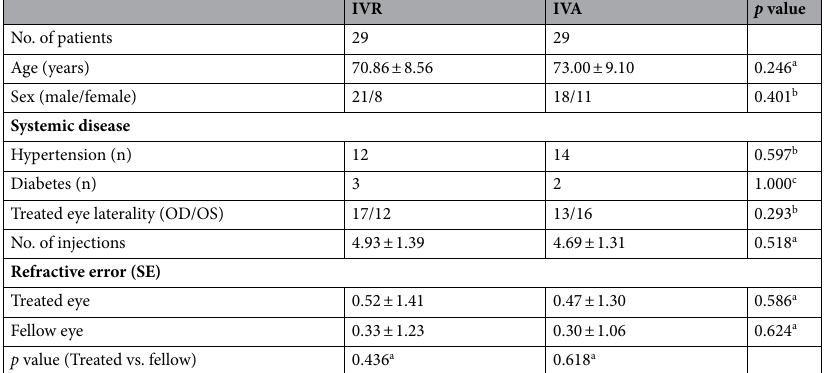
Table 1. Baseline characteristics of all patients who received intravitreal injections. OD, right eye; OS, left eye; SE, spherical equivalent; IVR, group that received intravitreal ranibizumab injection; IVA, group that received intravitreal aflibercept injection. a p value derived from Mann–Whitney U -test. b p value derived from Pearson’s Chi-square test. c p value derived from Fisher’s Exact